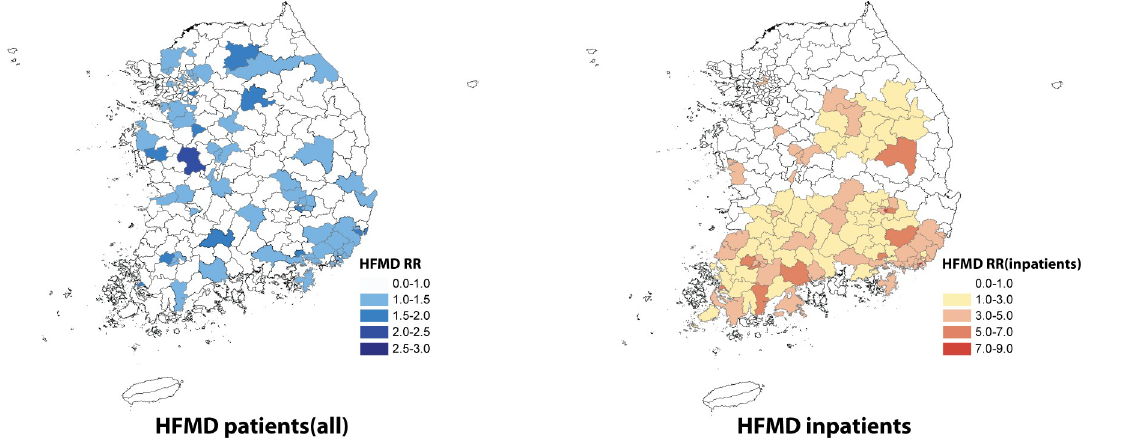
Fig 4. Relative risk maps for HFMD,